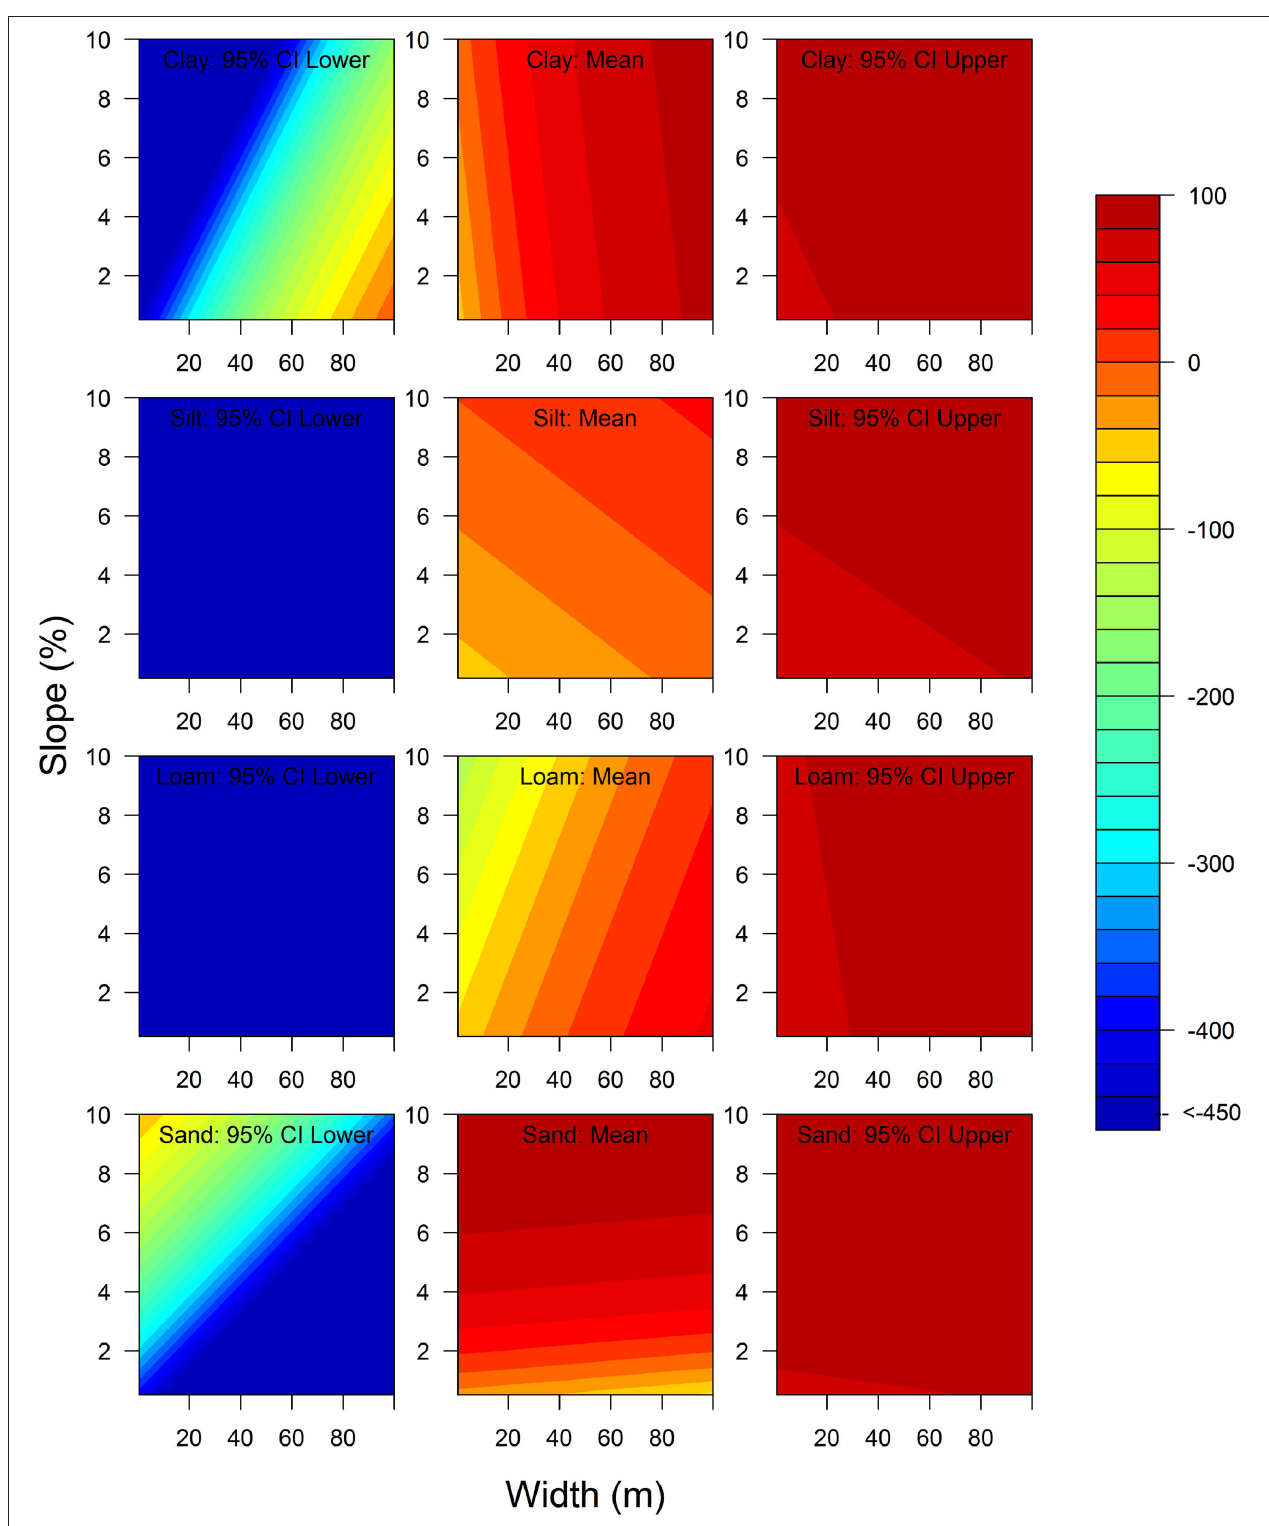
FIGURE 6 | The contours of P removal efficacy (mean and the 95% confidence interval) given RB width, slope, and soil type for the RBs installed adjacent to the fields without P application.